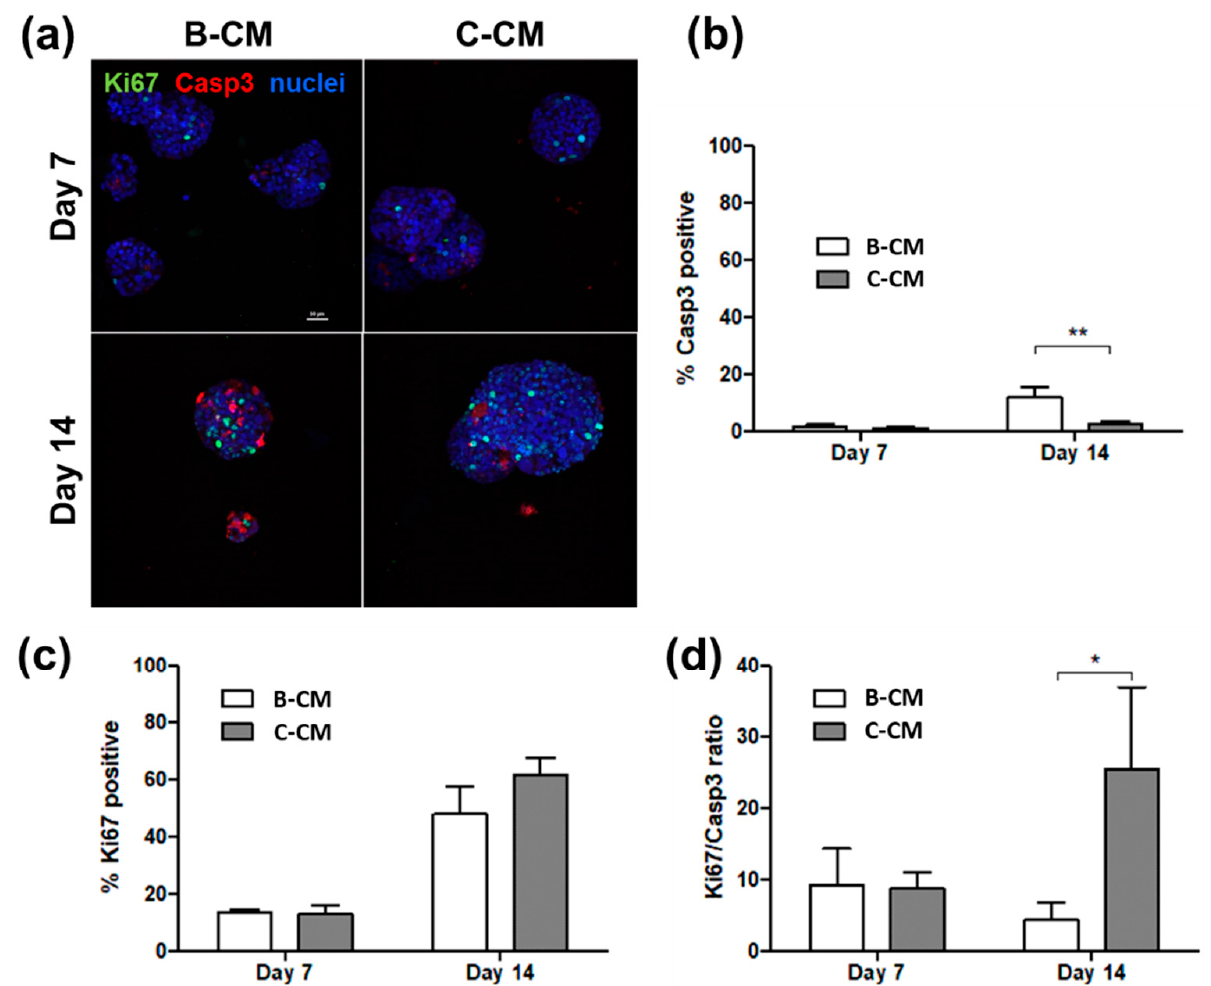
Figure 4. BMEC-conditioned media increases the number of Casp3+ cells. B-CM- and C-CM- treated cultures were fixed and stained for Ki67 and cleaved Casp3 ( a ). IMARIS analysis confirms an increase in Casp3+ cells on day 14 in B-CM ( b ), with a slight but not significant decrease in Ki67 ( c ). Accordingly, the Ki67/Casp3 ratio is different between the two conditions, with B-CM Ki67/Casp3 being near 1 ( d ). Scale bar = 50 µ m. Graphs represent means + SD. Statistical significance using two-tailed Student’s t -test, * p < 0.05, ** p < 0.01.